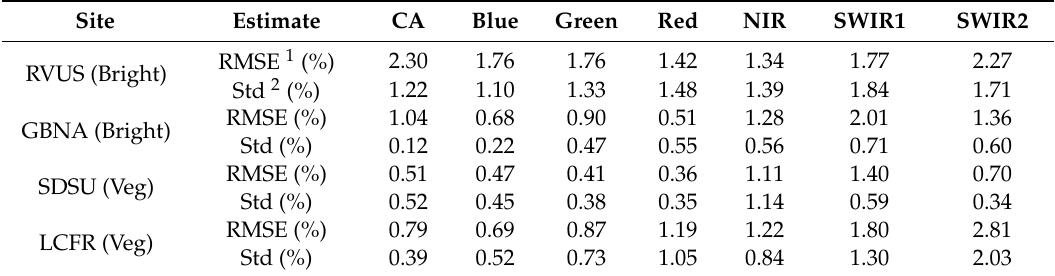
Table 4. Root-mean-square error (RMSE) and standard deviations for individual ground truth sites.